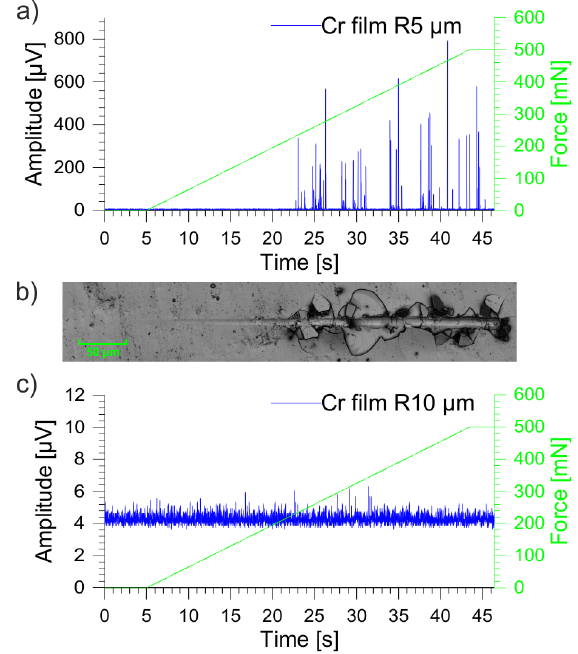
Figure 4. Cr thin film: a) AE envelope b) correspond- ing residual scratch groove made during the scratch test up to 500 mN with a sphere of radius of 5 µm, and c) AE envelope for the test performed up to 500 mN with a sphere of radius of 10 µm.